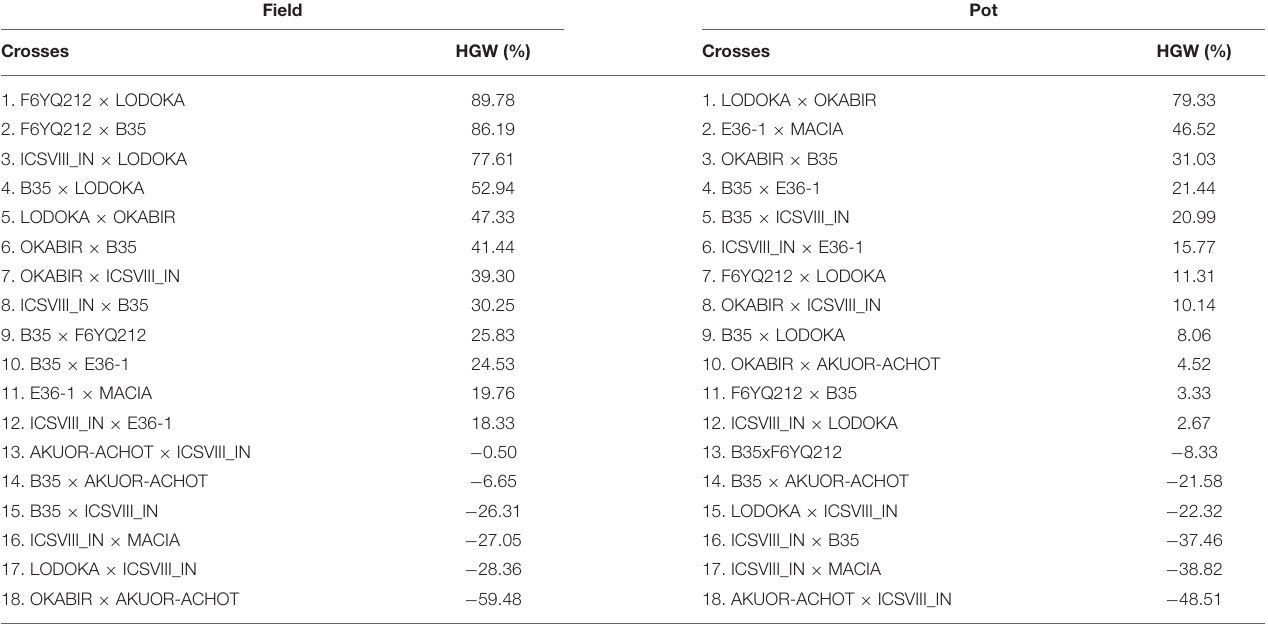
TABLE 5 | Proportion of residual heterosis at F 4 for 100-grain weight (HGW) for the pot and field trials.